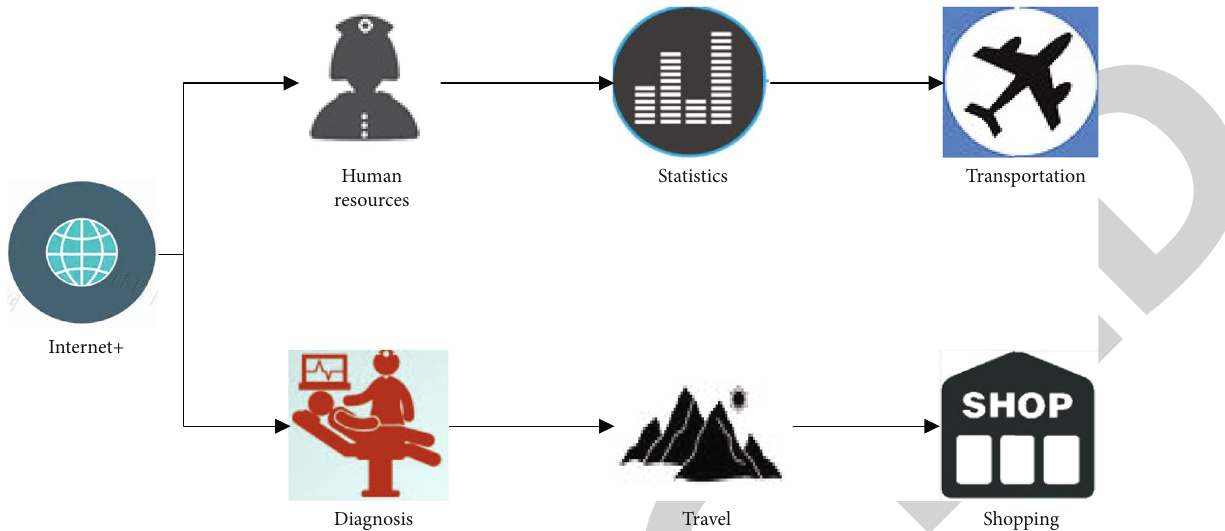
Figure 1: Industrial organization diagram involved in